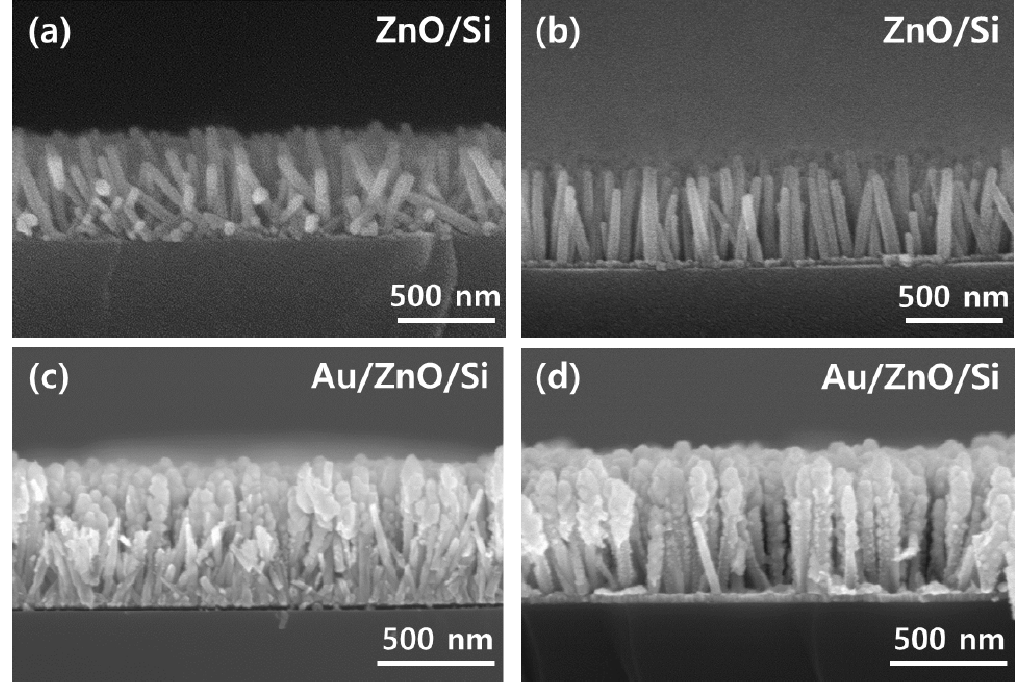
Figure 3. Cross-sectional SEM morphology of the fabricated nanorod structures: ( a ) spin-seeded nanorods before Au deposition, ( b ) sputter-seeded nanorods before Au deposition, ( c ) spin-seeded nanorods after Au deposition, ( d ) sputter-seeded nanorods after Au deposition.